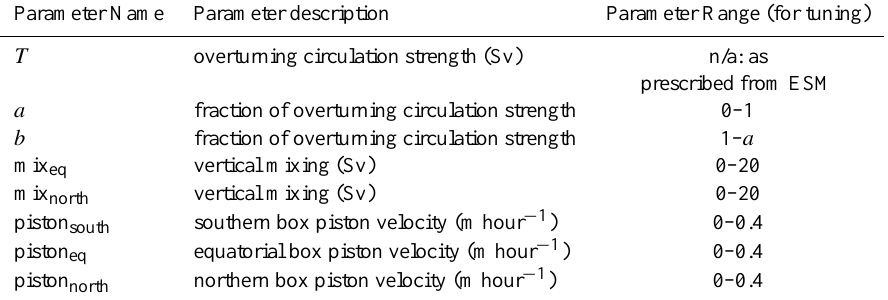
Table 1. Parameters used in box